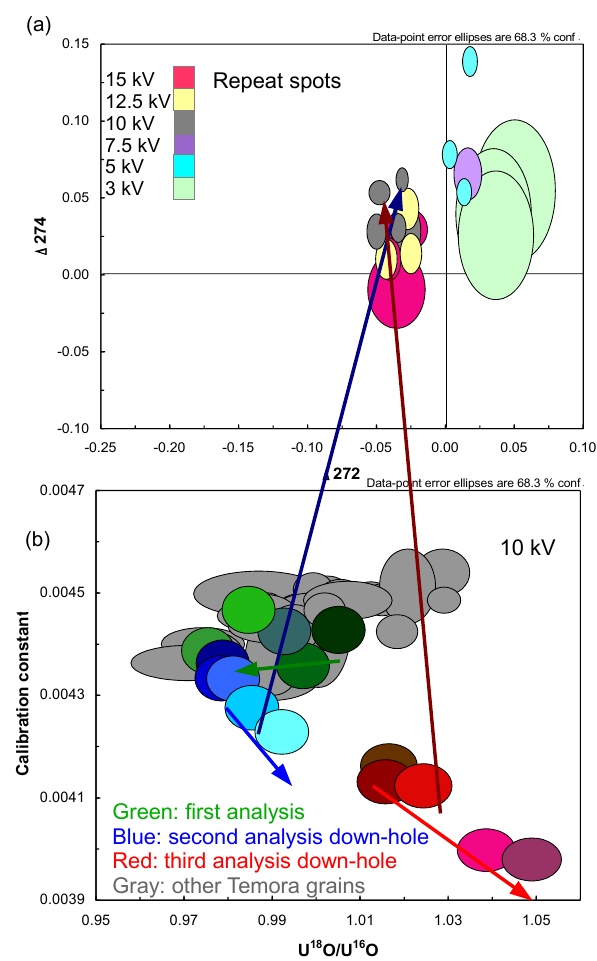
Figure 6. (a) (cid:49) 272 vs. (cid:49) 274 plots for multiple zircon analyses down the same hole under a variety of primary acceleration ener- gies. (b) U 18 O + / U 16 O + vs. calibration constant on a scan-by- scan basis for three downhole analyses. Grey ellipses are single- scan data for individual, non-repeated